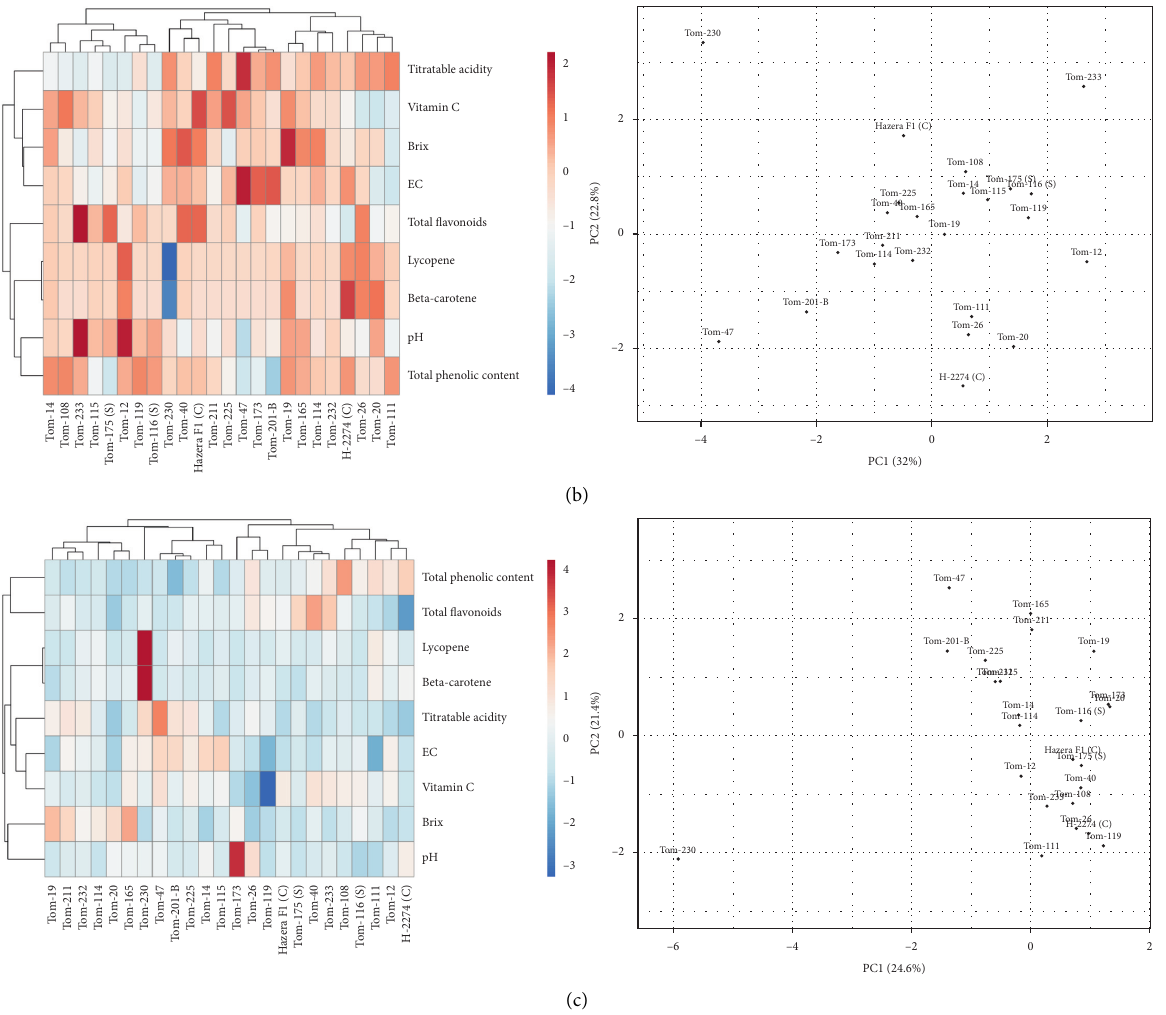
Figure 4: Heat map cluster (left) and principal component analysis (PCA) plot (right) of quality parameters profiles of control (a), high temperature (b), and relative change